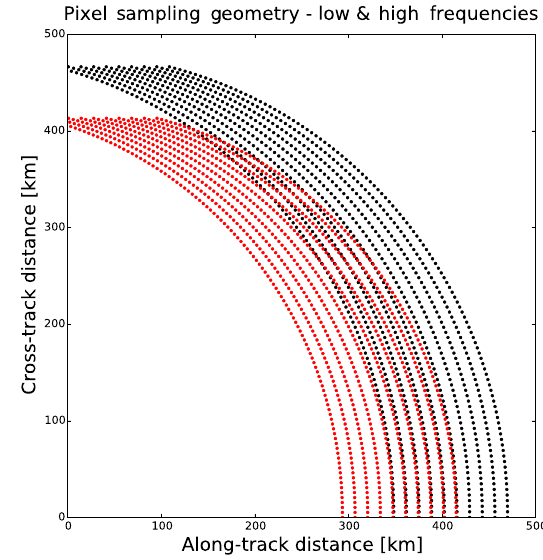
Figure 2. The modeled spatial relationship between pixel centers for 10.65–89 (black) and 166–183.3GHz (red). The horizontal axis gives along-track distance from an arbitrary starting point; the ver- tical axis gives cross-track distance measured from the satellite sub- track.